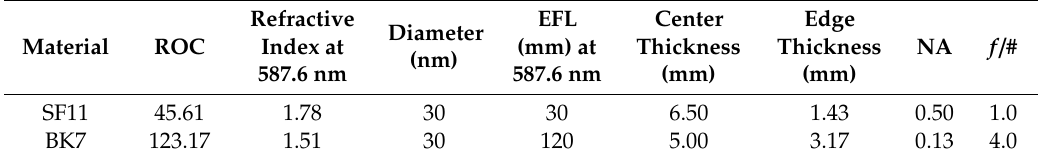
Figure 1. ( a ) Schematic illustration showing the antireflection coatings on both sides of the bi-convex lens, and scanning electron microscope (SEM) image of fabricated SiO 2 nanostructures on the BK7 lens. Scale bar is 300 nm. ( b ) Photographic images of SF11 and BK7 lens with bare and DARCs, respectively. Scale bar is 15 mm. ( c ) Measured transmittance spectra of optical lenses in Figure 1b. ( d ) Schematic illustration of designed optical system, including three double-convex lenses: two BK7 lenses and one SF11 lens. The image at the bottom-right is the surface light source with a mask for the object. ( e ) Optical images at the image plane, in Figure 1d, with three bare optical lenses and three DARCs lenses, respectively. ( f ) Comparison of measured intensity spectra of dashed line in Figure 1e. Table 1. Information of optical lenses.